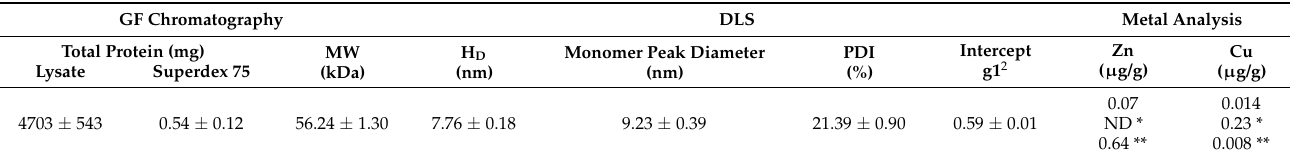
The total protein was estimated by the Warburg–Christian method using absorbance at 260/280 nm. To estimate the molecular weight of Tyrp2 (kDa), we pre-calibrated the Superdex 200 Increase 10/300 column with the GF Bio-Rad standards: thyroglobulin (670 kDa), γ -globulin (158 kDa), ovalbumin (44 kDa), myoglobin (17 kDa), and vitamin B12 (1.3 kDa). The hydrodynamic diameter (H D ), monomer peak diameter, polydispersity index (PDI), and the intercept g1 2 were calculated from DLS using the Kalliope Professional 2.2.3 software (Anton Paar, Graz, Austria). Metal analysis was done using ICP-MS analysis. * Tyr; **